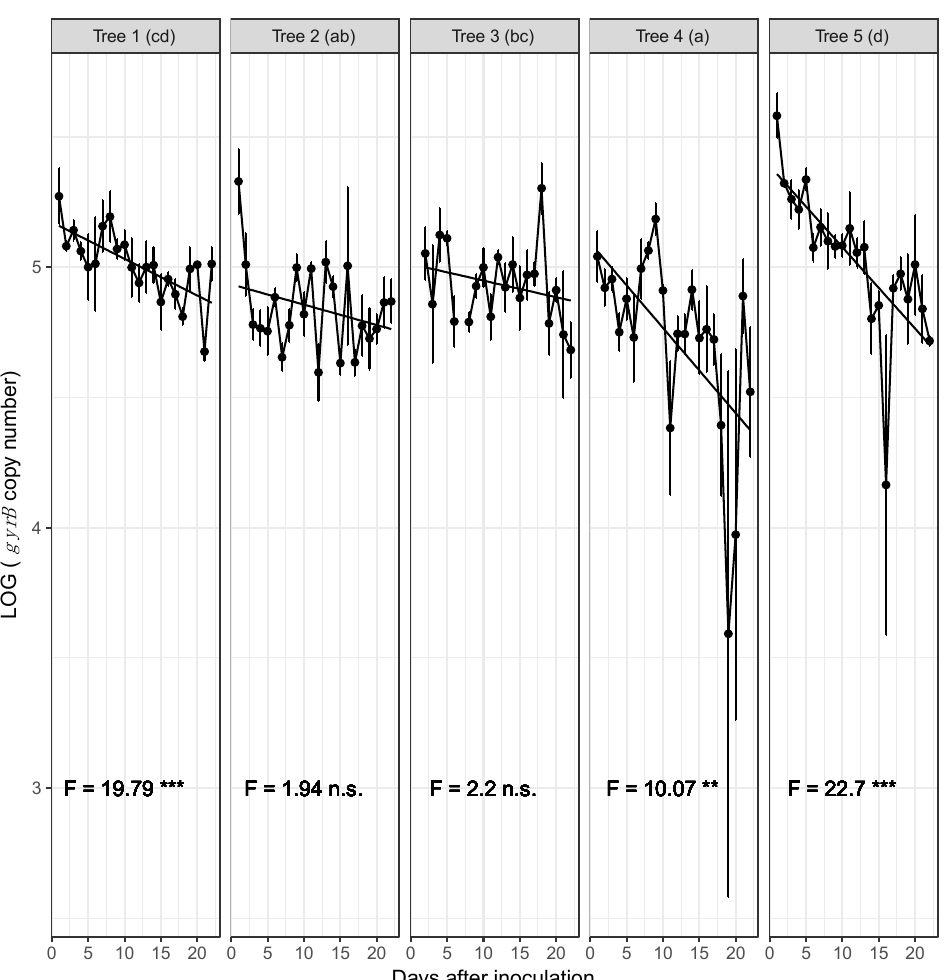
Figure 1. Gene copy numbers of the gyrase B (gyrB) gene targeted for daily detection of non-viable Pseudomonas syringae pv. aesculi cells on stem samples collected from five different trees over an incubation period of 22 days. Stem samples were collected for DNA extraction and quantitative PCR each day after inoculation with non-viable P . syringae pv. aesculi cells. F-values and significance (*** p < 0.001, ** p < 0.01, n.s. not significant) of the number of days after inoculation based on a linear fixed-effect model y~tree + day + (1|tree) are presented for each tree. For each tree, a smoothing line based on the linear model according to the number of days after inoculation has been added. Trees with different lower-case letters differ significantly in P . syringae pv. aesculi